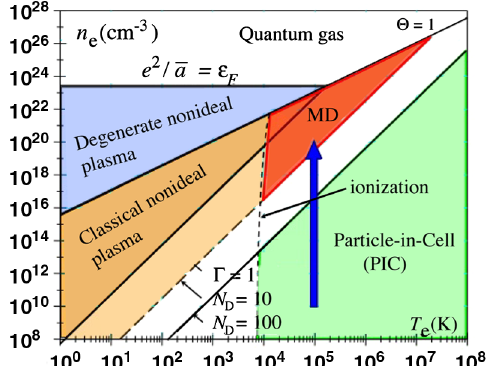
FIG. 1. The range of PIC and MD codes. The arrow shows the time development on an arc, as described in Refs.